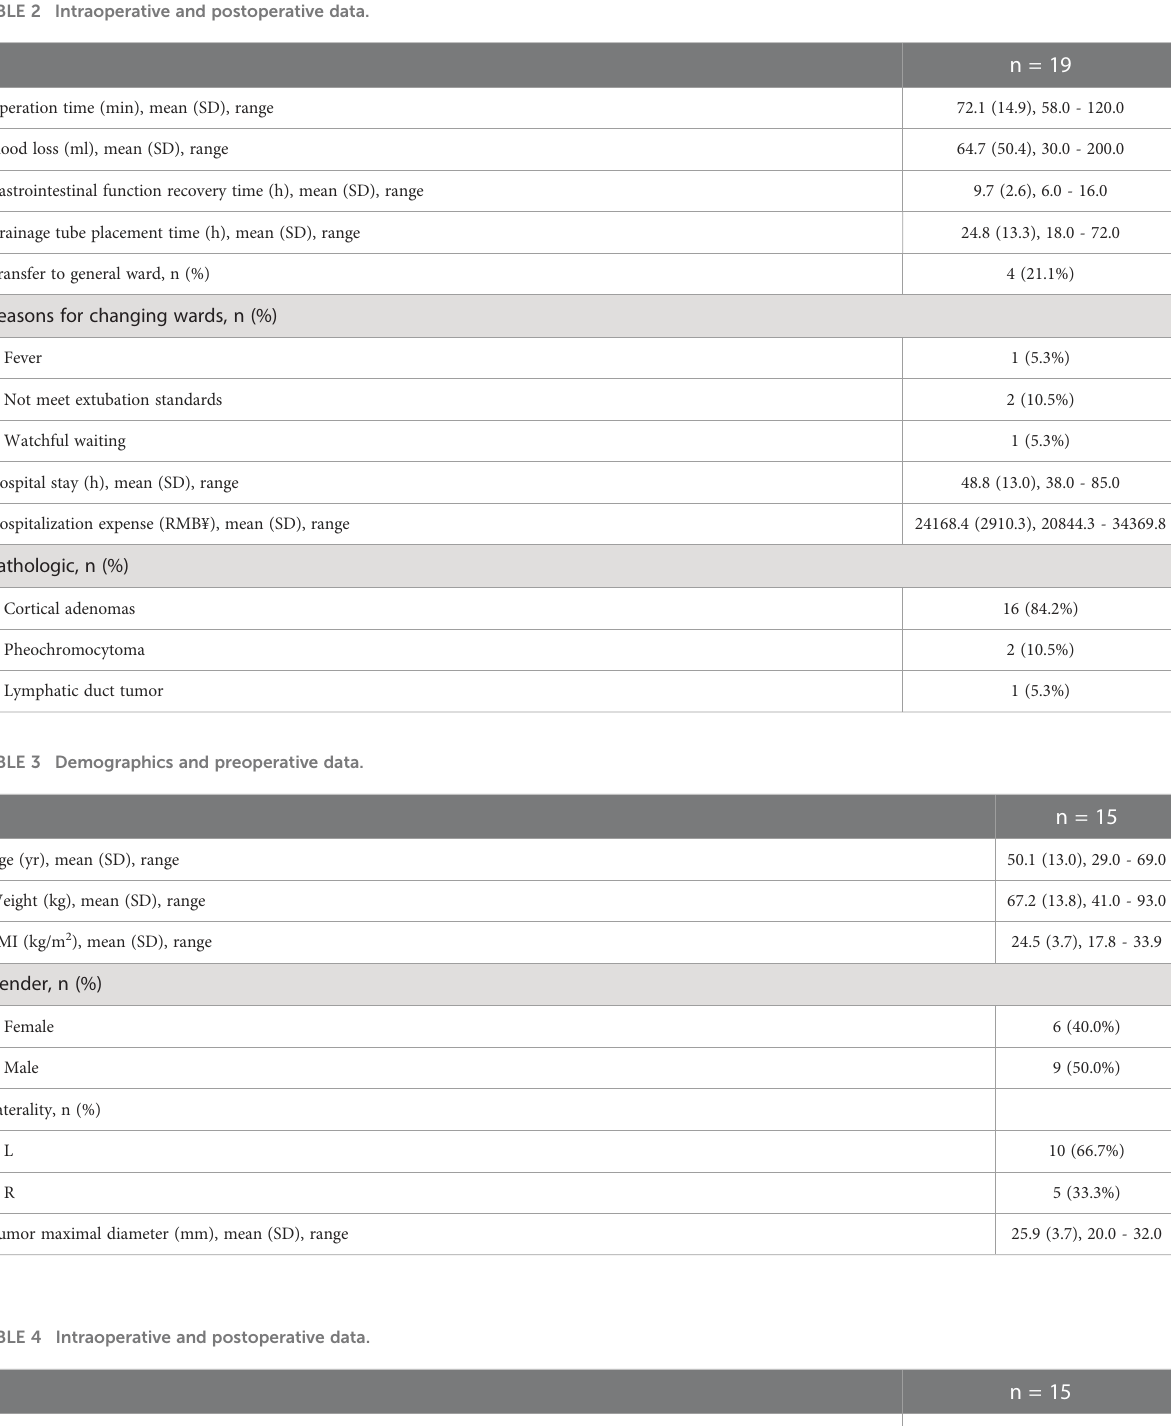
TABLE 2 Intraoperative and postoperative data.